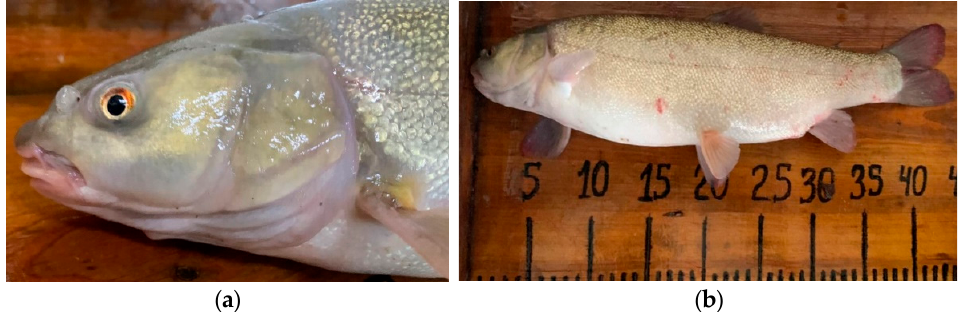
Figure 3. Balkhash Marinka S. argentatus: ( a ) the head from the side; ( b ) full length of the body. The Balkhash marinka belongs to the group of fish with a single-batch spawning [45]. The first sexually mature males are found at three years of age and the first sexually mature females in a four-year-old. The main part of males matures at four and five years and females at five and six years. According to our research, spawning in the Tokyrauyn River takes place from the middle of April to the second decade of May at a temperature from 9 to 11 ◦ C and above. In early May 2021, in catches, spawning females accounted for 70% of sexually mature specimens and 30% were females with reproductive products at maturity stage IV-V. According to bioanalysis results, sexually mature males were characterized by fluidity and the VI-II stage of maturity of sexual